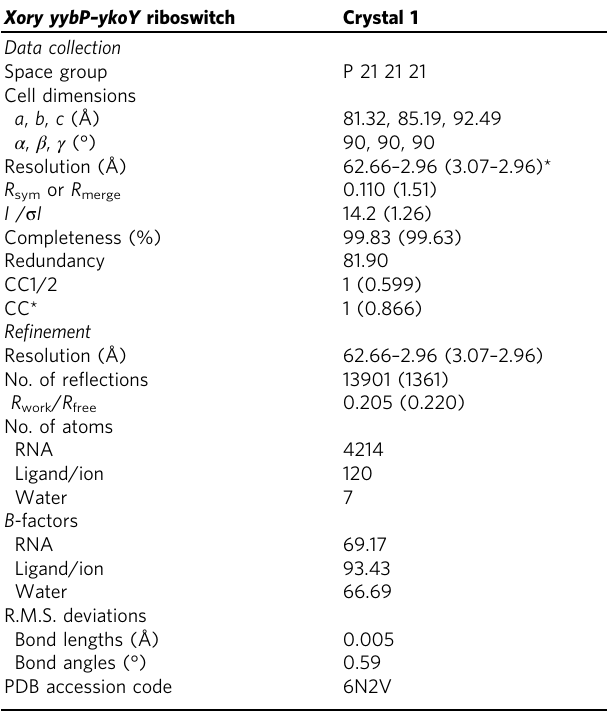
Table 1 X-ray crystallographic data collection and re fi nement statistics for the X. oryzae yybP – ykoY Mn 2